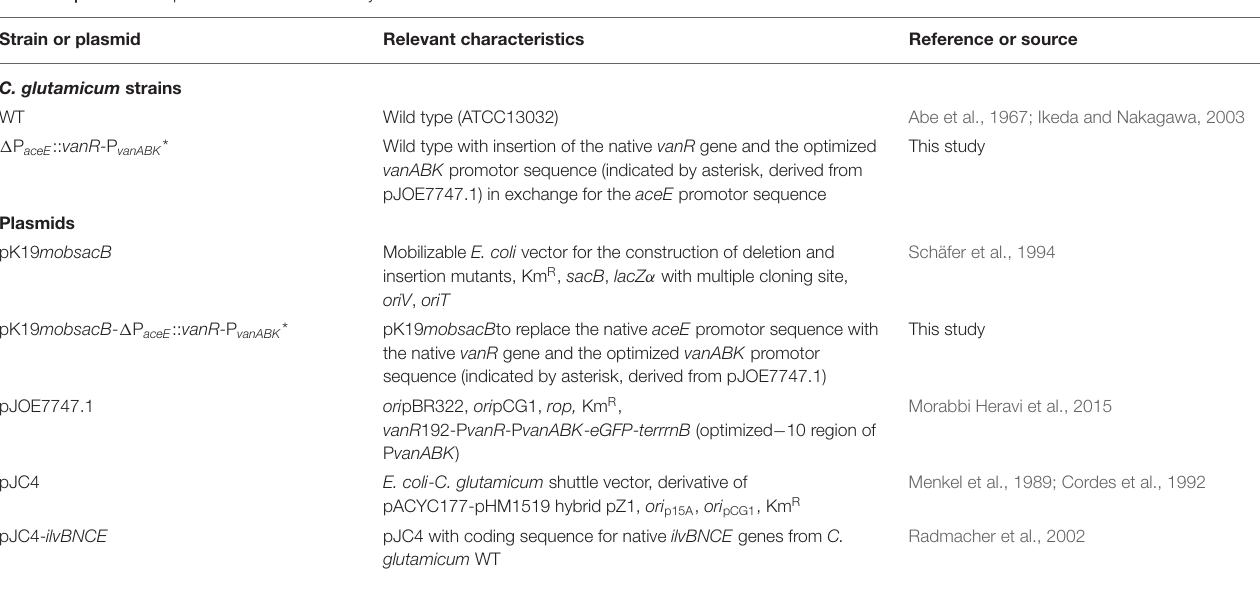
TABLE 1 | Strains and plasmids used in this